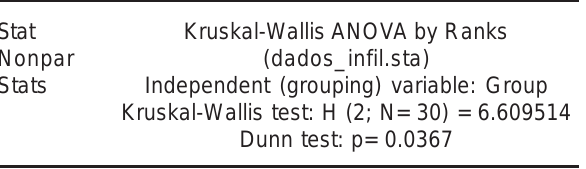
thicknessesDepend.: TABLE 4- Comparison among groups A (gray MTA), B (white MTA) and C (white Portland cement) for 5-mm-thick apical